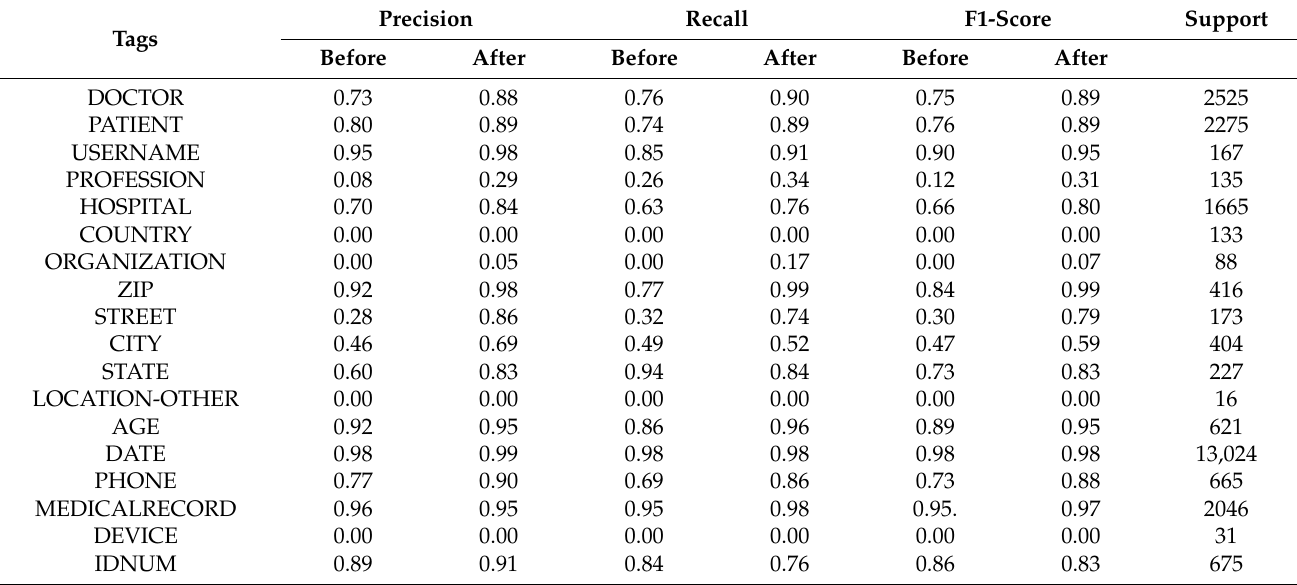
Table 4. Prediction performance by PHI entity before filtered BERT